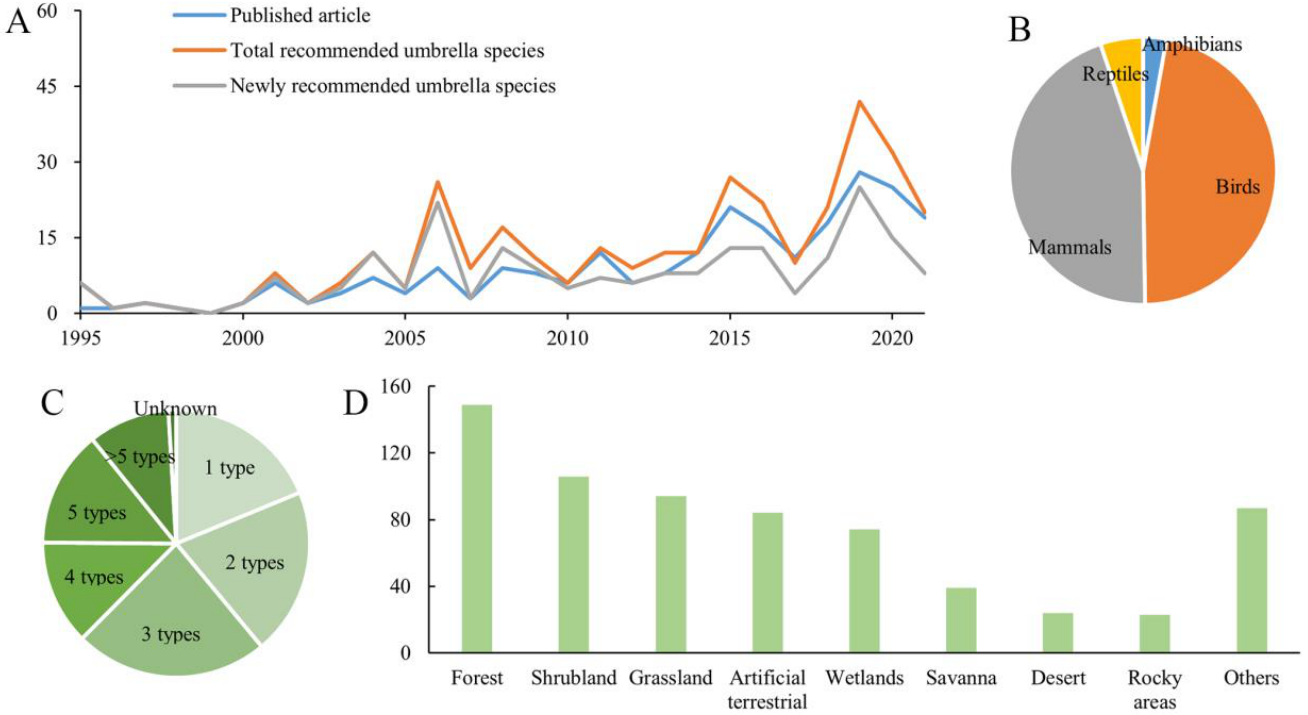
Figure 1. The yearly number of published articles with umbrella species as study species indexed by Science Citation Index Expanded, as well as the yearly number of total and newly (excluding umbrella species that had been proposed before) recommended umbrella species since 1984 to 2021 ( A ), the proportions of 213 recommended umbrella species across different taxa ( B ), the proportions of recommended umbrella species that use varying types of habitat ( C ), and the number of species for each type of habitat ( D ).